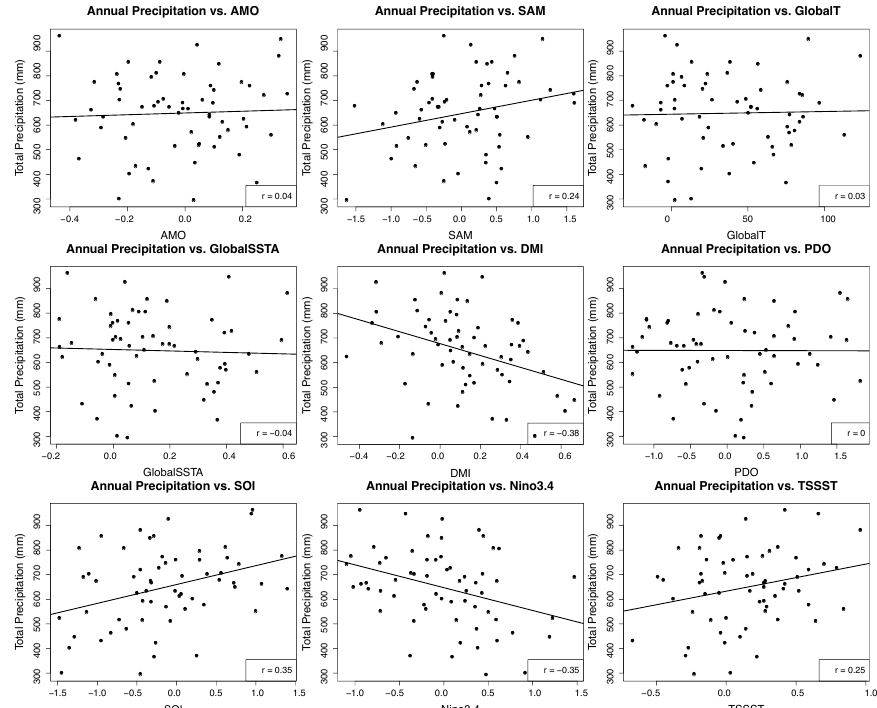
Figure 1. Scatter plot of annual precipitation in Canberra against each climate driver that serve as possible attributes, showing non-linear relationships between precipitation and the climate drivers. The thin black line is a linear fit against the data using least squares regression. Correlations of each predictor against precipitation are provided in the box to the lower right of each sub-panel, low correlations ( | r | < 0.3) indicate little linear relationship between a predictor and precipitation.